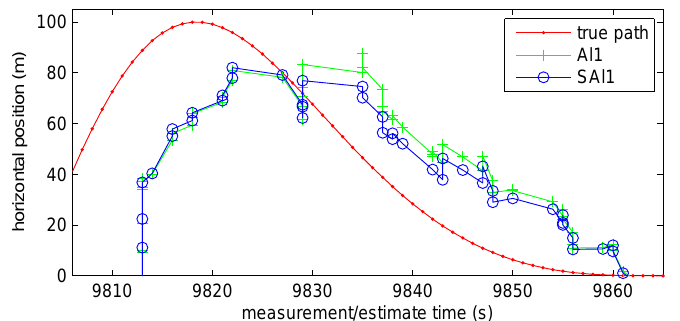
Figure 9. Performance of SAl1 filter compared with Al1